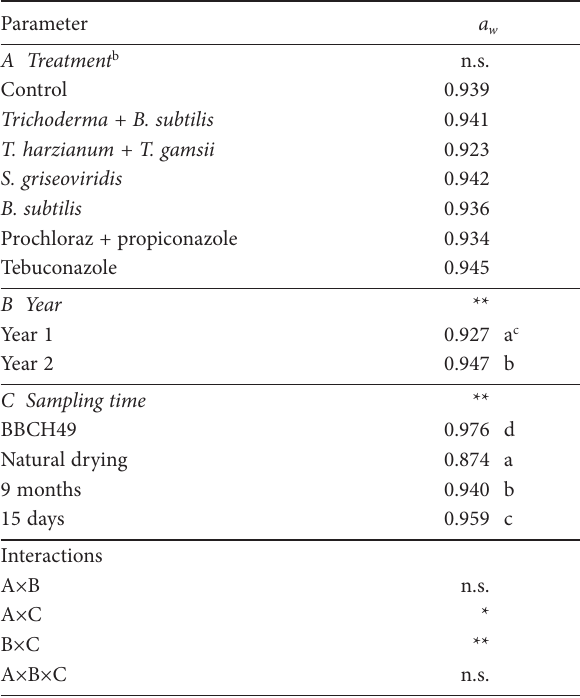
dient (mean BPSI = 32.1%) and gave similar disease lev- els as prochloraz + propiconazole (35.0%) and bacterial BCAs (35.4%).